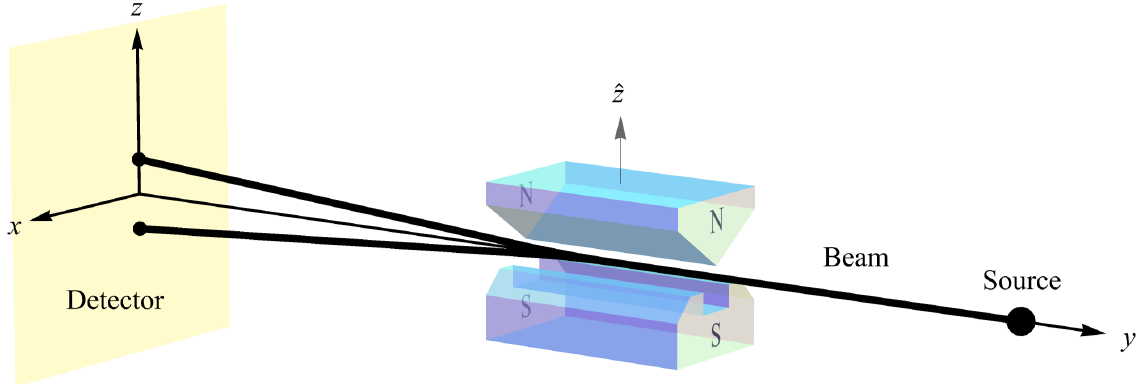
) and down ( − ℏ ) or + 1 and − 1 , 2 2